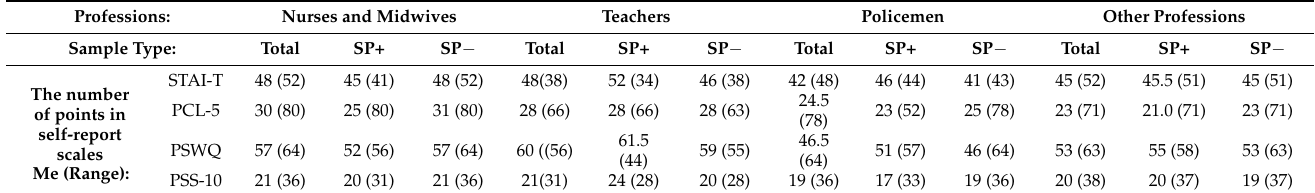
Table 4. The number of points in self-report scales among participants by profession